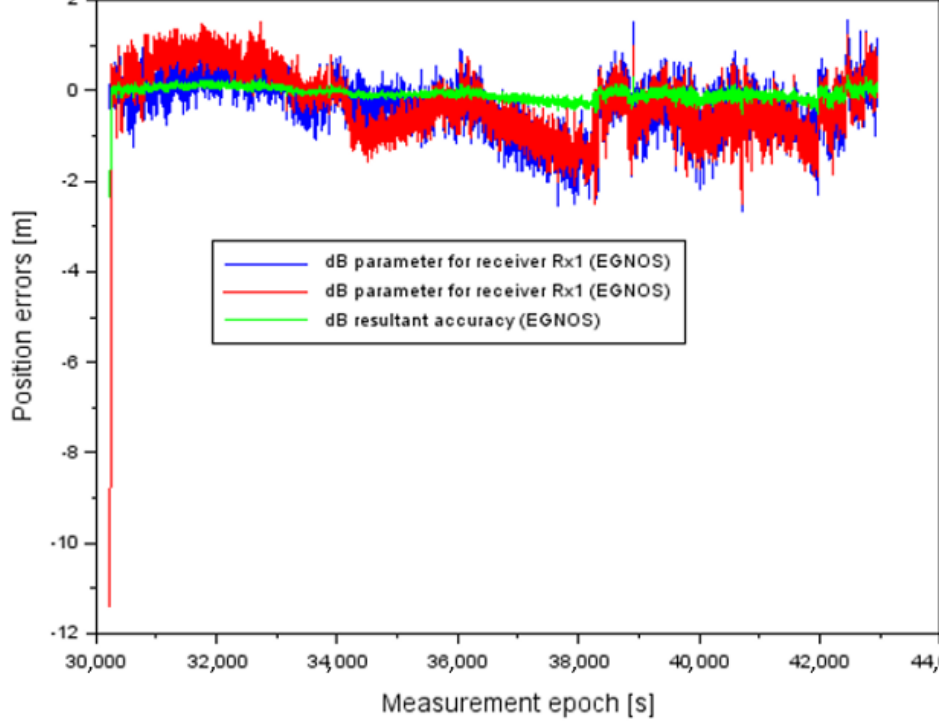
Figure 14. The results of 𝑑𝐵 position errors for EGNOS solution.